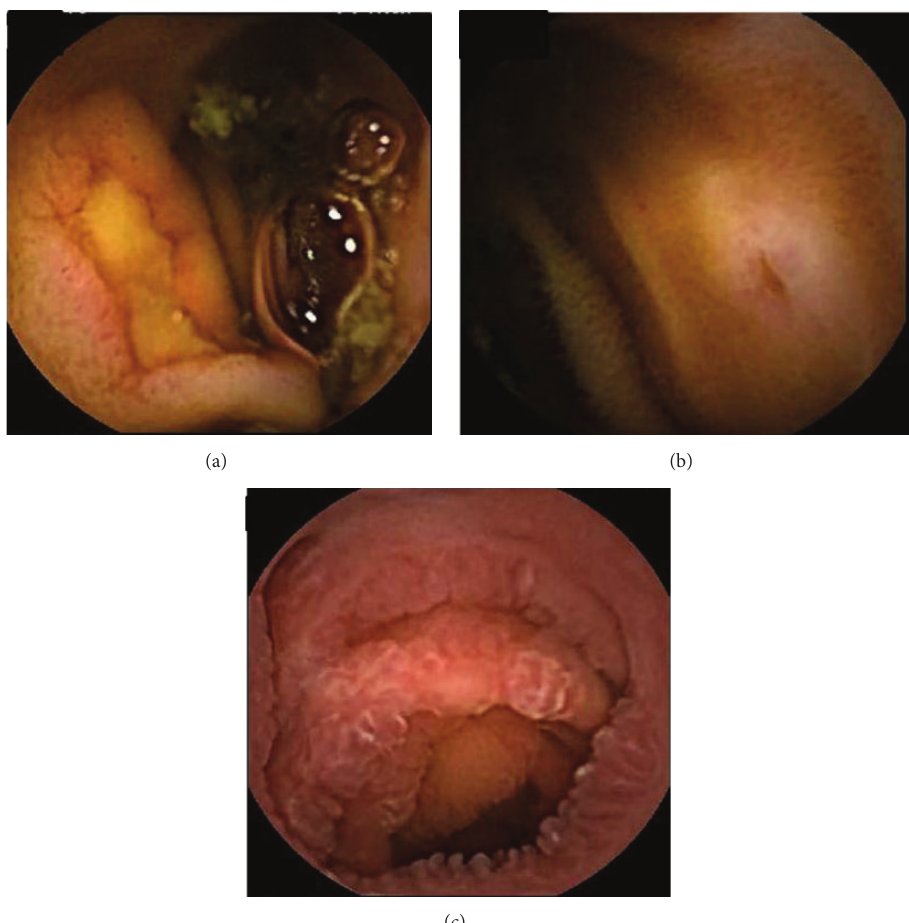
Figure 1: (a–c) Video capsule endoscopy findings for ileitis: (a) ulcer, (b) erosion, and (c) edematous